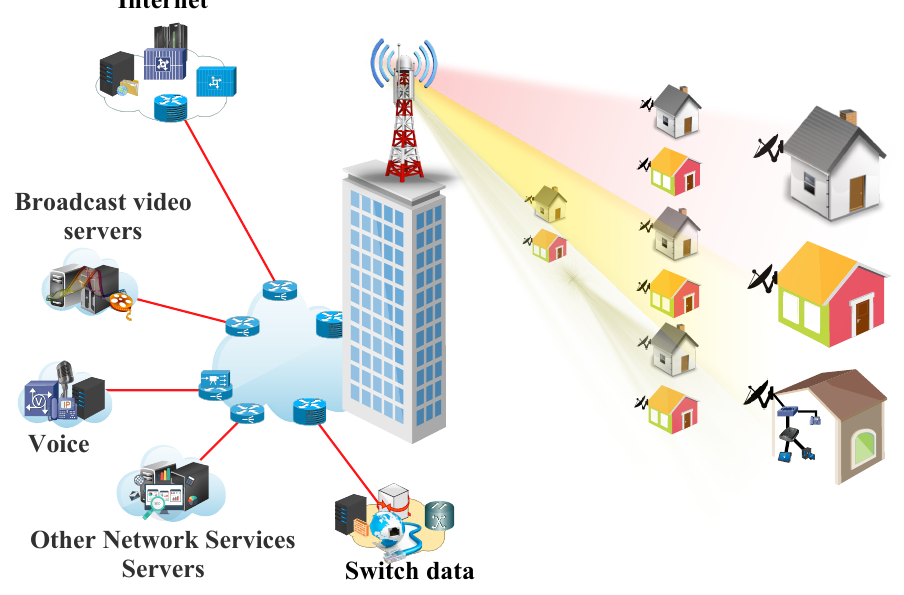
Figure 5. A typical LMDS